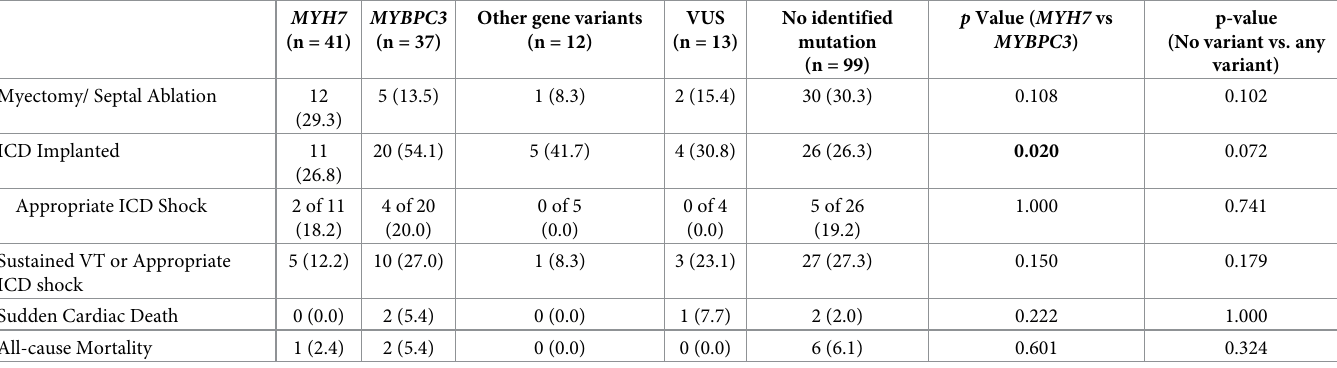
Table 5. Clinical outcomes by genetic testing result.